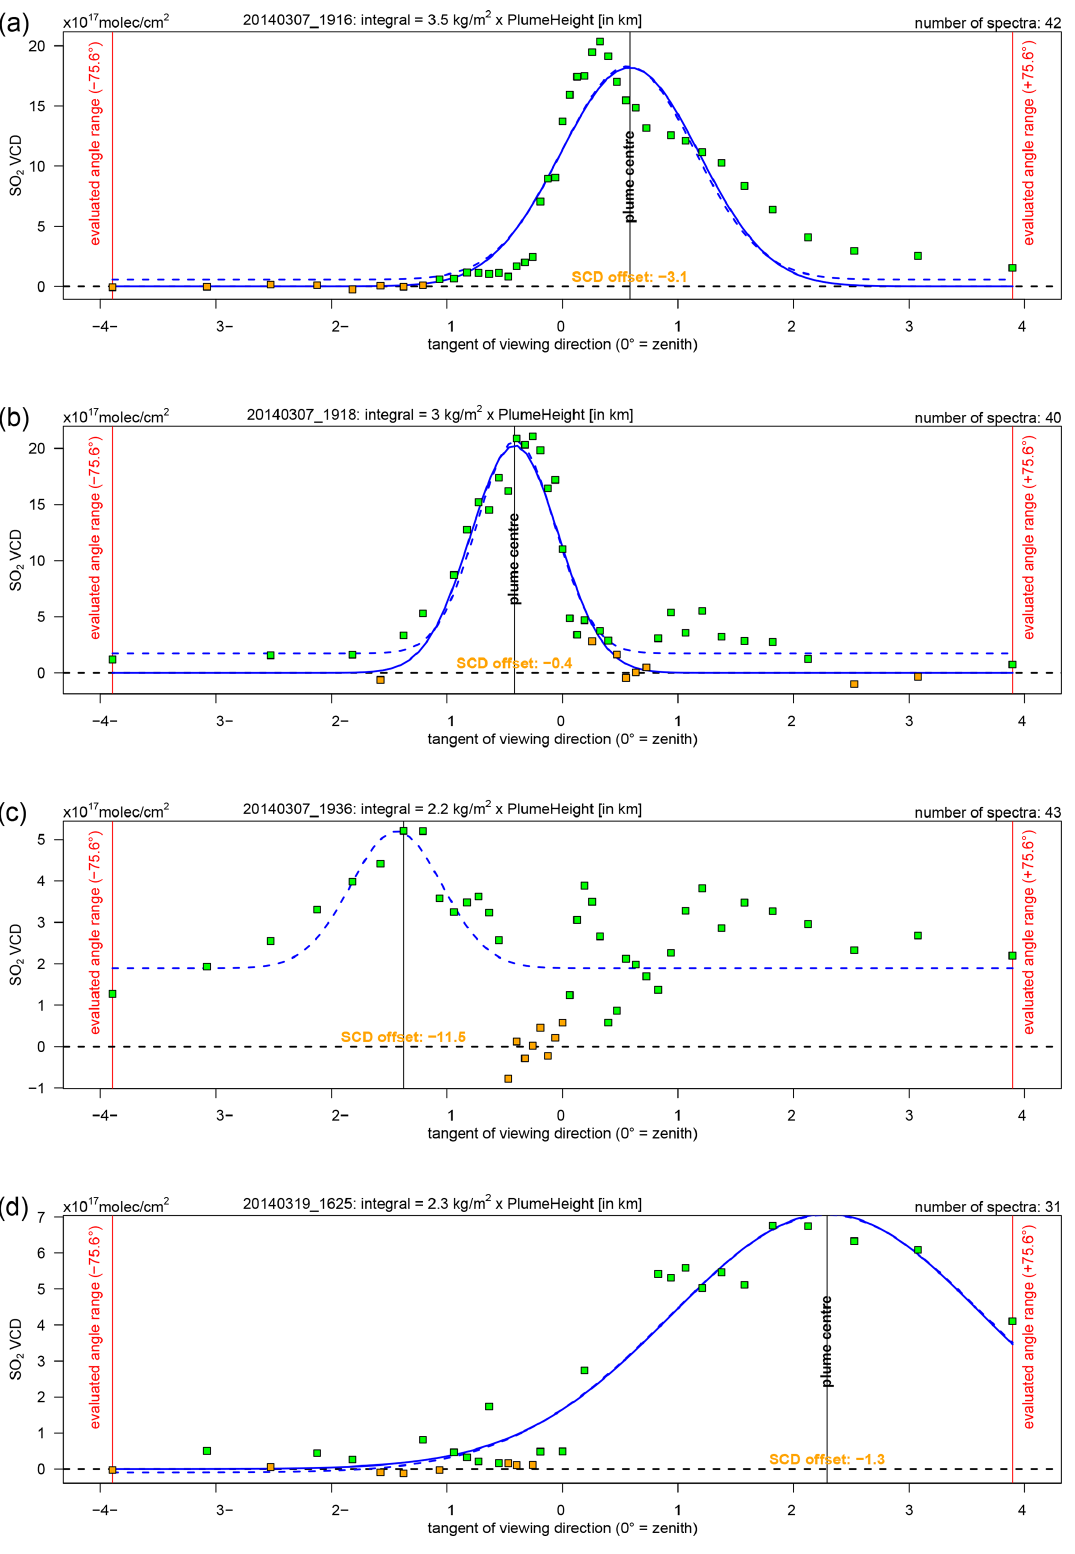
Figure D3. SO 2 distribution retrieved (a) from the scan starting at 7 March 2014 19:16UTC recorded at Nancital station and (b–d) from the scans starting at 7 March 2014 19:18UTC, 7 March 2014 19:36UTC, and 19 March 2014 16:25UTC recorded at Caracol station.